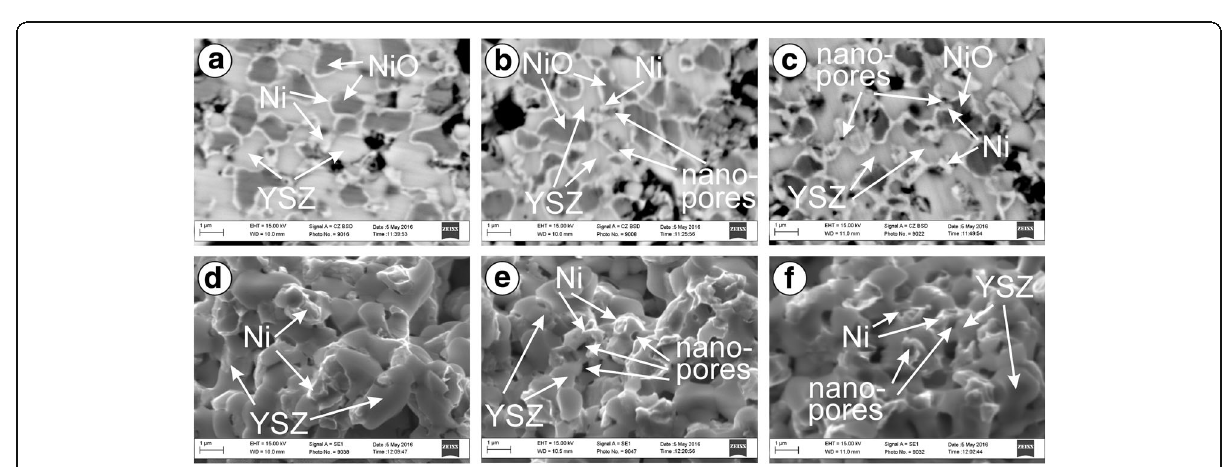
Fig. 3 SEM a – c structure and d – f fractographies of specimens preconditioned by one-time reduction, after a , d mode 1, b , e mode 2, and c , f mode 3 test (see Table